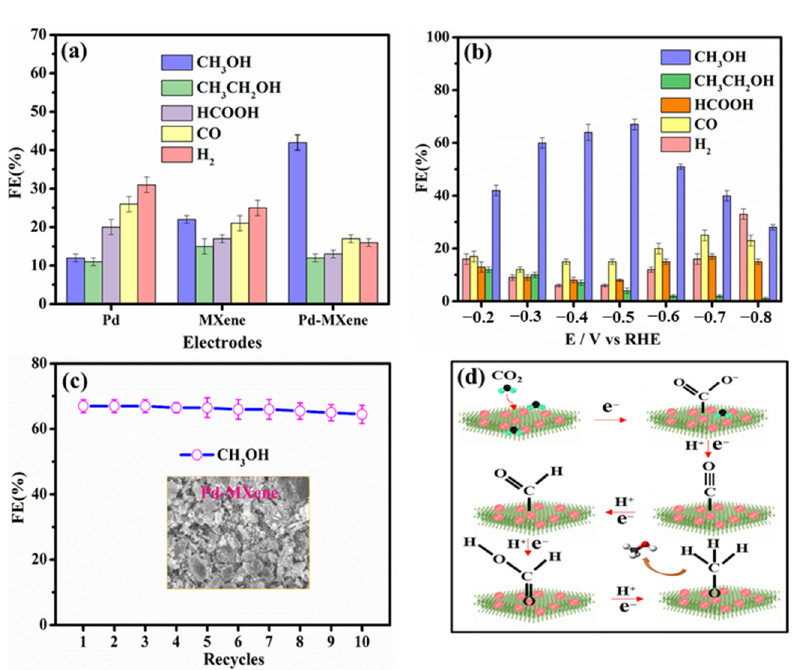
Figure 5. ( a ) Faradic efficiency of CO 2 RR products performed at − 0.2 V vs. RHE over Pd, MXene, and Pd-MXene electrodes, ( b ) different potentials ( − 0.2 to − 0.8 V vs. RHE) versus FE of CO 2 RR products using Pd-MXene electrodes, ( c ) recycle studies over 10 consecutive cycles performed at − 0.5 V vs. RHE using Pd-MXene electrodes, and ( d ) reaction pathways for the CO 2 RR process over Pd-MXene electrode. All experiments used 1.0 M NaHCO 3 as the electrolyte either with or without CO 2 . The cathodic potential of − 0.5 V vs. RHE effectively reduces CO 2 to selectively